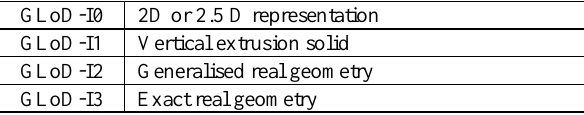
Table 4: Levels of Detail for the geometric representation of